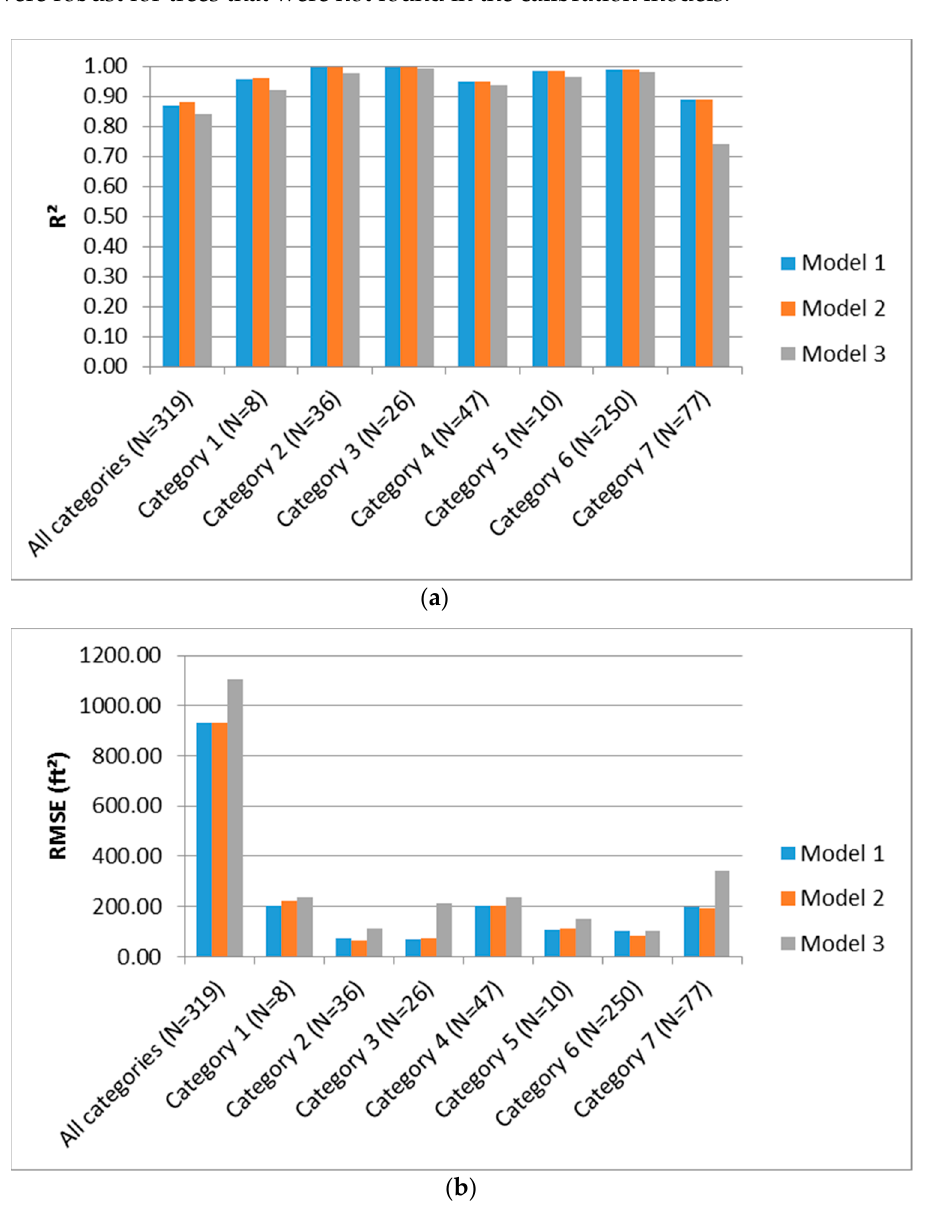
Figure 6. R 2 ( a ) and RMSE ( b ) of three models on seven tree categories.